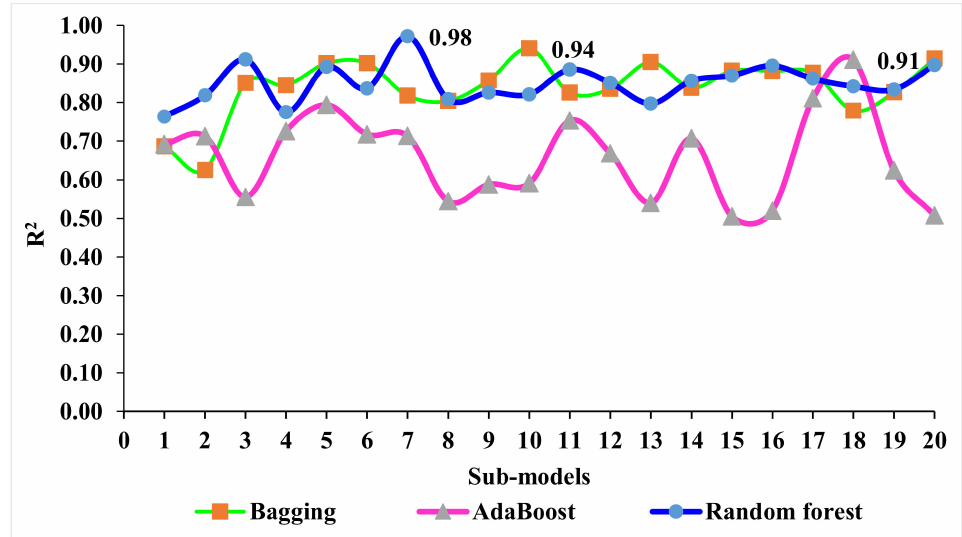
Figure 15. R 2 values of